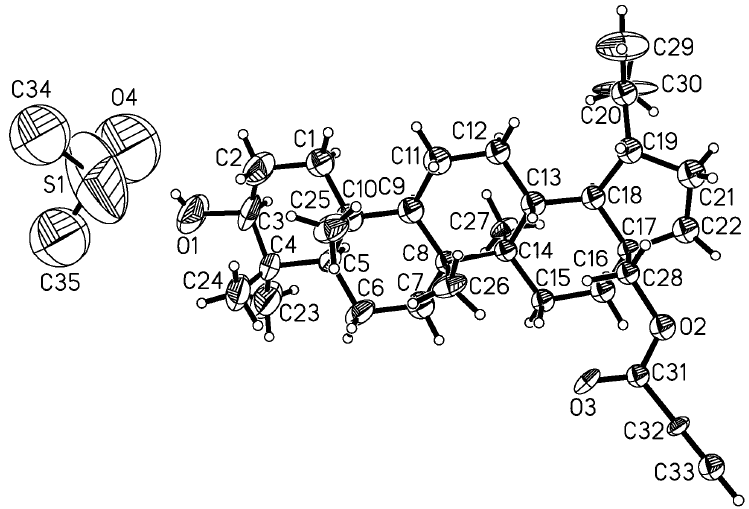
Figure 2. Molecular structure with atomic numbering scheme of 28- O -propynoylbetulin – DMSO solvate 5a with displacement ellipsoids of 50%